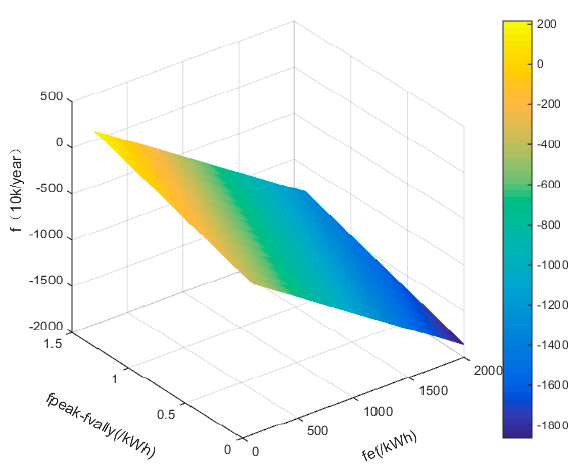
Figure 7. Relationship between annual profit and two influencing factors.